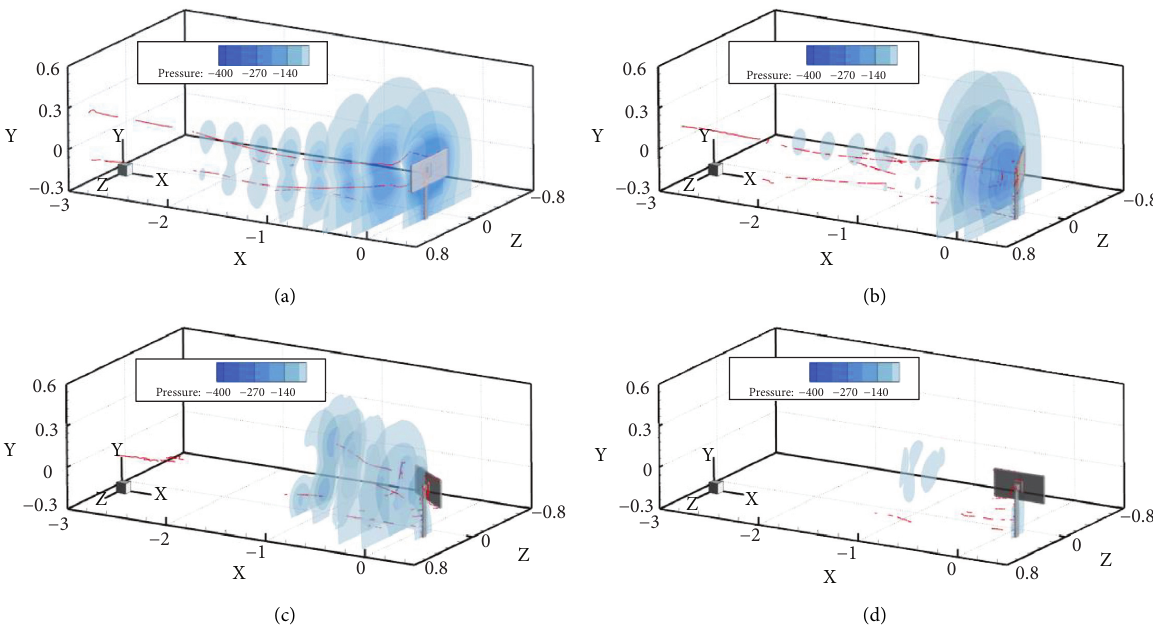
Figure 14: Vortex core track and static pressure YOZ multisection pressure nephogram distribution with azimuth angle. (a) β � 0 ° , (b) β � 30 ° , (c) β � 60 ° , and (d) β � 90 °